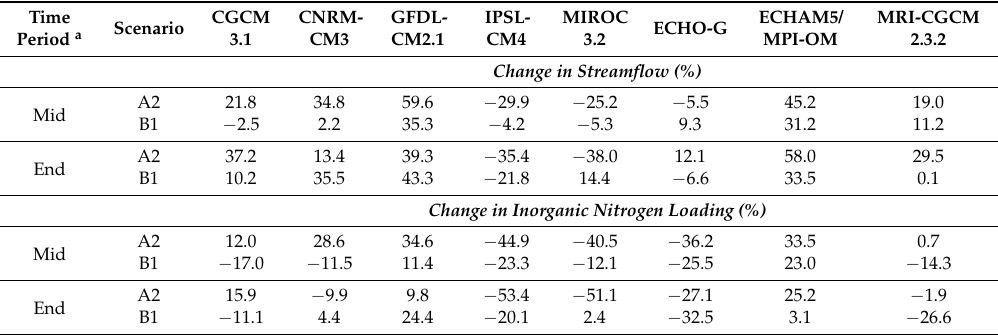
Table 3. Simulated changes in streamflow (%) and inorganic nitrogen loading (%) under future climate scenarios from the eight GCMs used in this study [37].